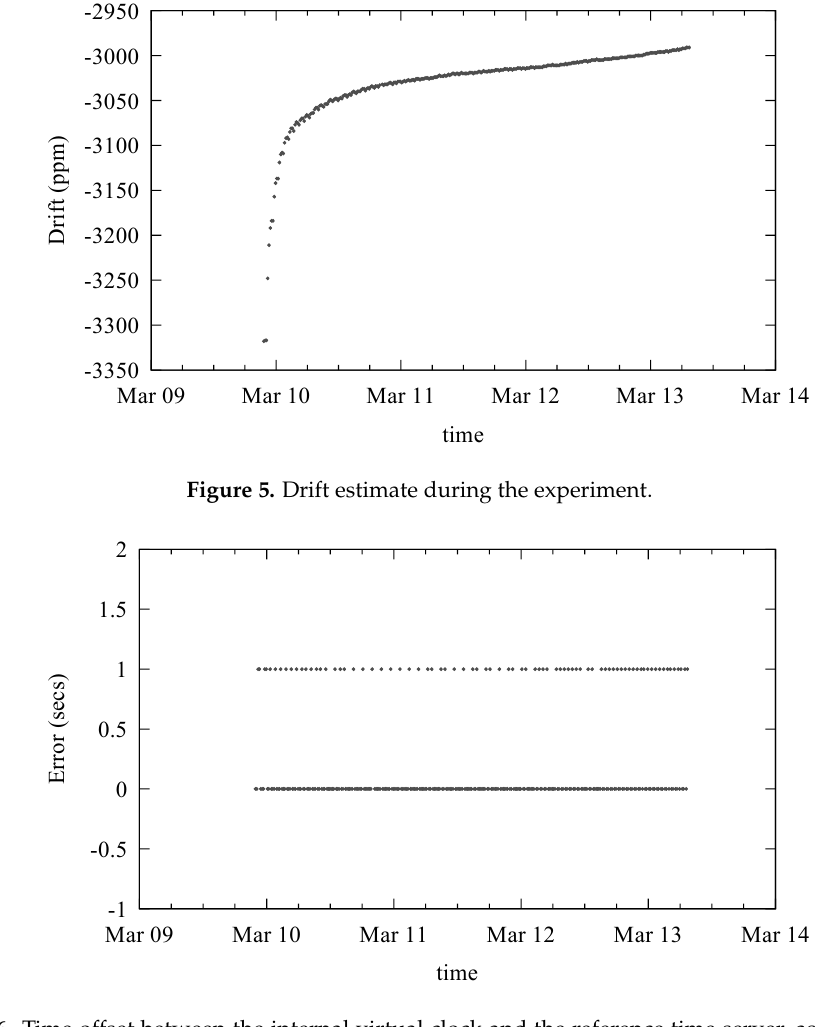
Figure 6. Time offset between the internal virtual clock and the reference time server, as measured during clock